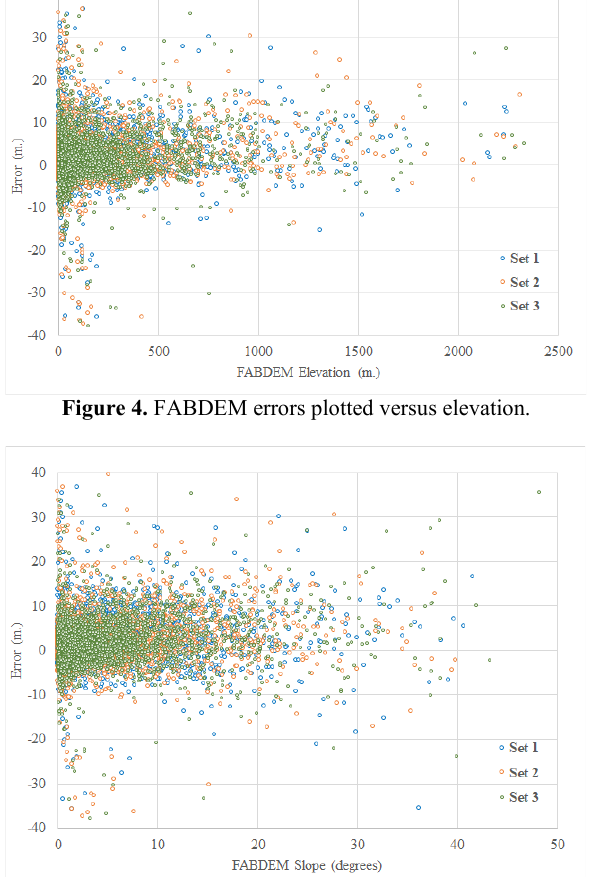
Figure 5. FABDEM errors plotted versus slope.